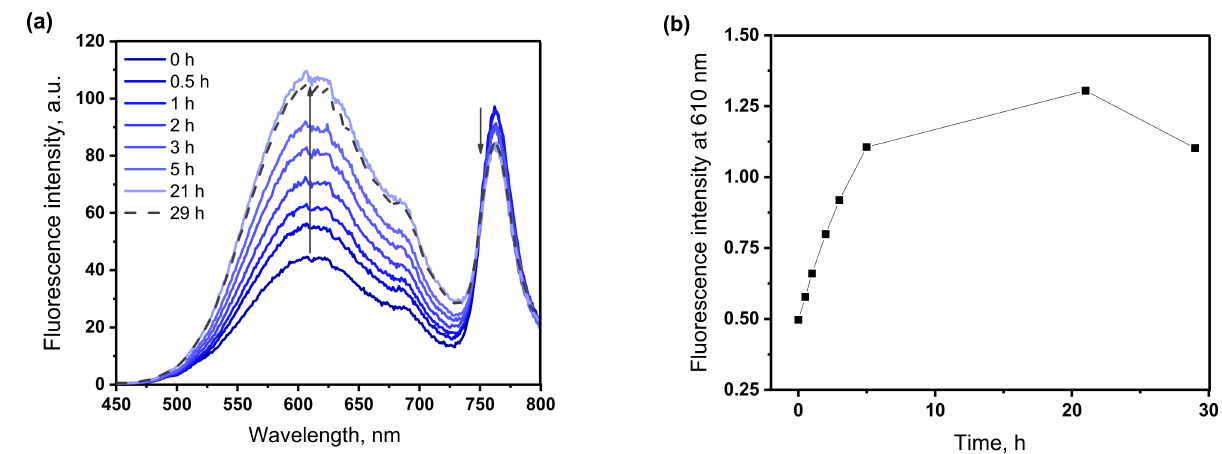
Figure 4. Time-dependent fluorescence emission spectra ( a ) of BChl–S–S–NI (5 µ M) toward glu- tathione (5 mM), from 0 to 21 h; ( b ) changes in fluorescence intensity of BChl–S–S–NI at 610 nm upon exposure in presence of 5 mM glutathione HEPES buffer solution (0.01 M, pH 7.4) at 37 ◦ C with 1% Triton X100.